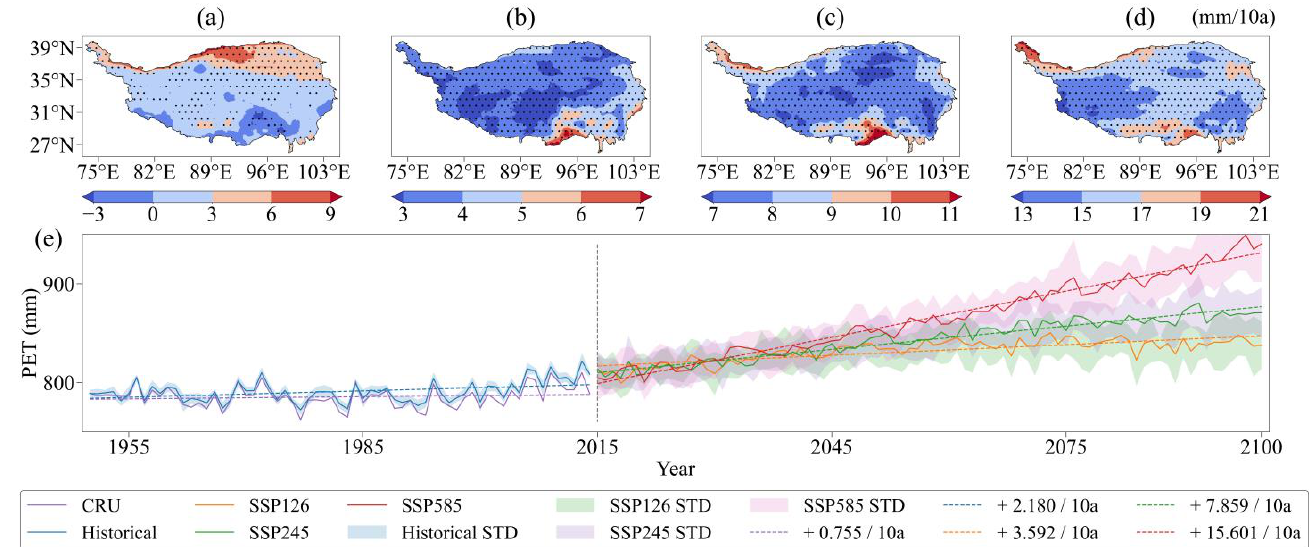
Figure 11. Trend test results of total precipitation for the HQ-corrected ensemble model. ( a – d ) represent the spatial trend of precipitation in the historical and future scenarios, respectively. The black dots are significant points with p < 0.05. ( e ) represents the change curve of the precipitation of the ensemble model in the historical and future scenarios. The filling on both sides of the line represents the respective standard deviation, and the dashed line is the trend line.